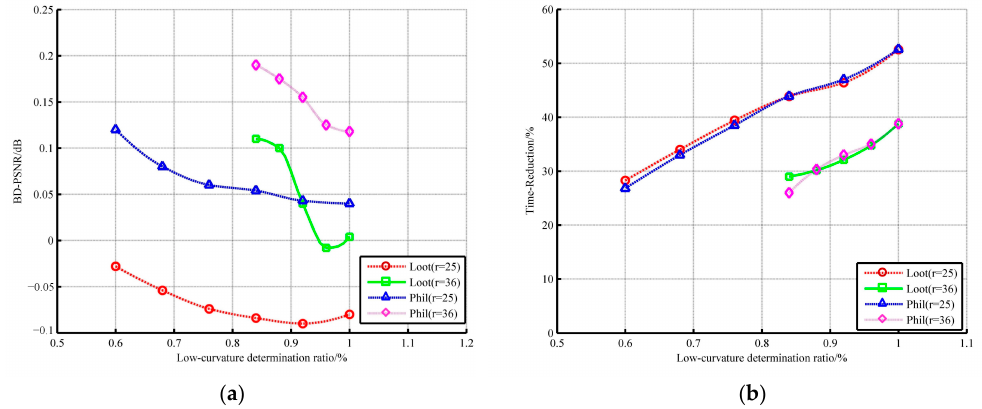
Figure 11. The influence of low-curvature determination ratio on ( a ) geometry performance; ( b ) time.